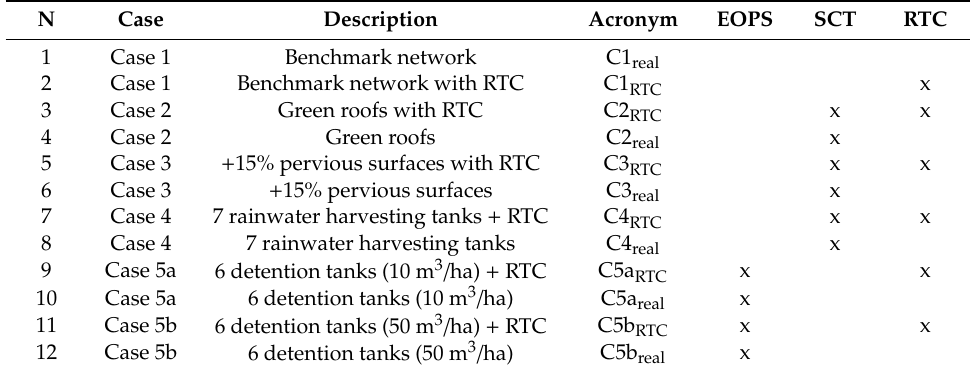
Table 4. Conditions simulated for each scenario, including end-of-pipe solution (EOPS), source control technology (SCT), and real-time control (RTC) systems.